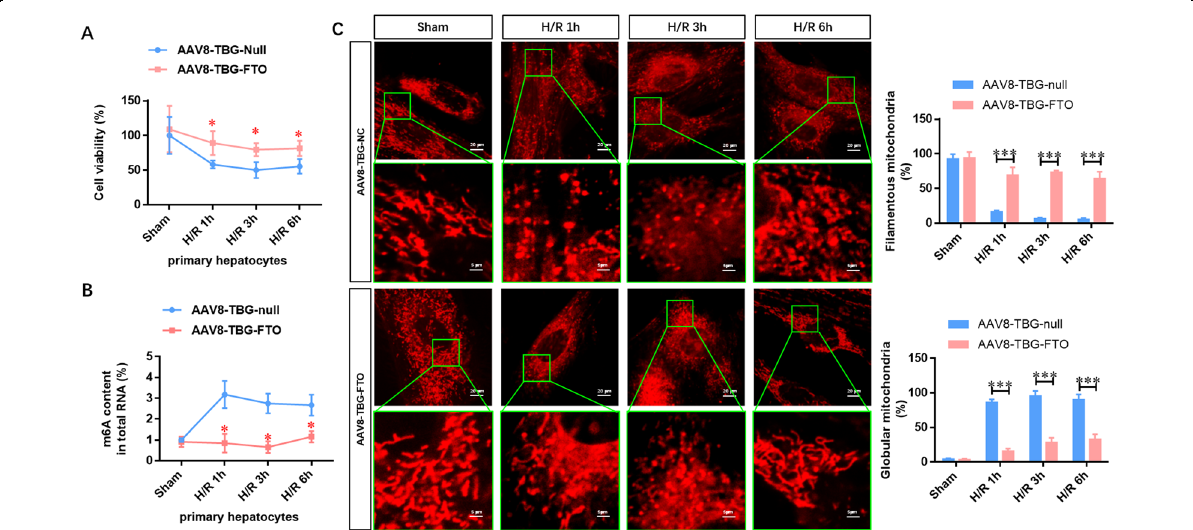
Fig. 4 FTO overexpression alleviates the IRI-impaired cell viability and attenuates mitochondrial fragmentation. A Cell viability in the hepatocytes infected with control AAV8-TBG-null and AAV8-TBG-FTO during IRI was detected by CCK-8 assays. B The total level of methylated RNA (m6A) in hepatocytes was detected by EpiQuik m6A RNA Methylation Quanti fi cation Kit. C Confocal microscopy was used to analyze the elongated, intermediate, fragmented mitochondria of cardiomyocytes infected with control AAV8-TBG-null and AAV8-TBG-FTO during IRI. N = 3; * P < 0.05 and *** P < 0.001 vs. AAV8-TBG-NC